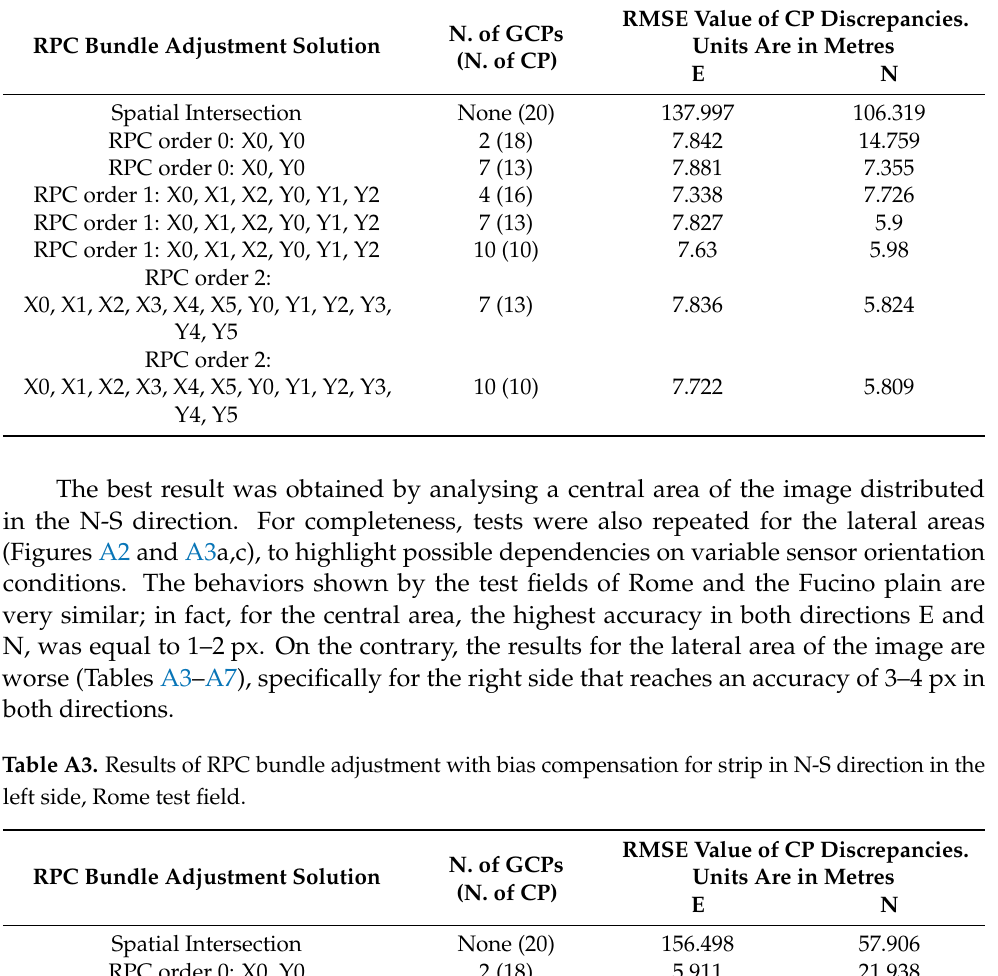
Table A2. Results of RPC bundle adjustment with bias compensation for strip in N-S direction, Rome test field.